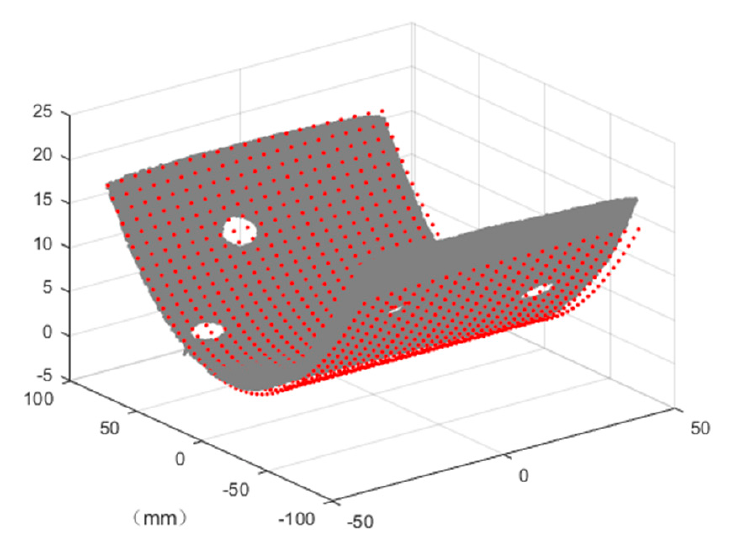
Figure 5. Deformation of the laminate, curved surface–3D scanning, discrete points–Analytical modal.